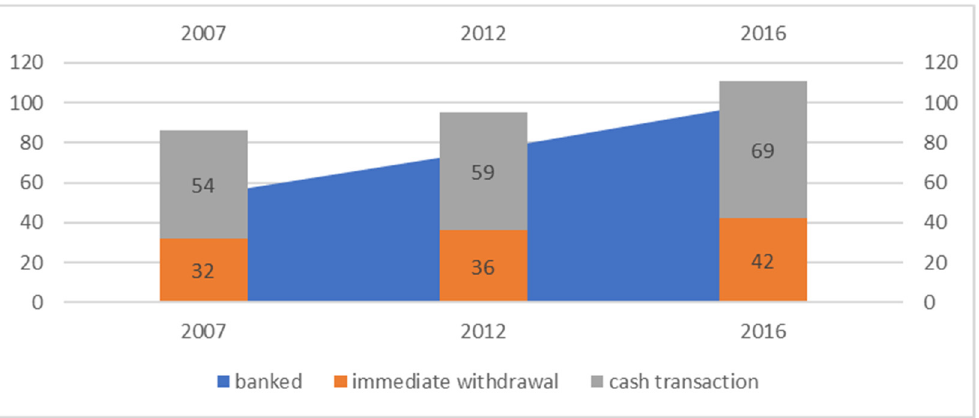
Figure 4. Cash dependency among grant recipients. Source of data: (FinMark Trust 2015, 2016, 2018).